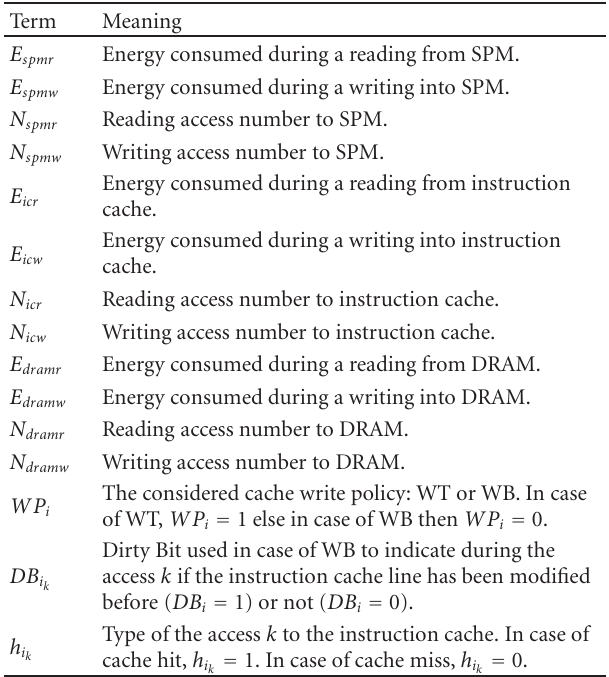
Table 6: List of